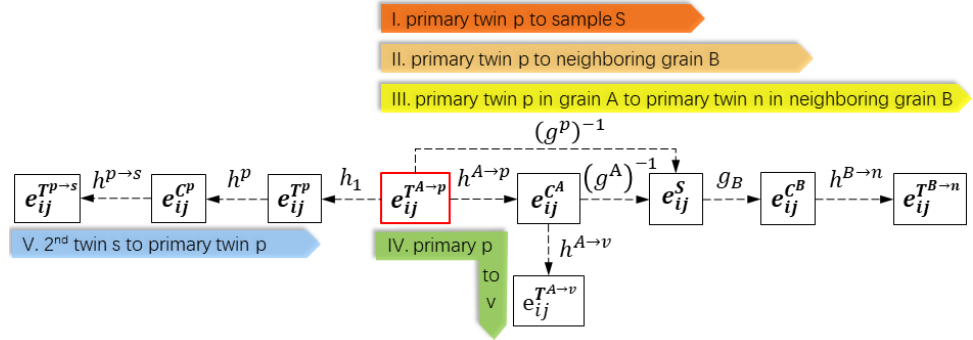
Figure 2. Procedures for calculating twin-related strain accommodation.